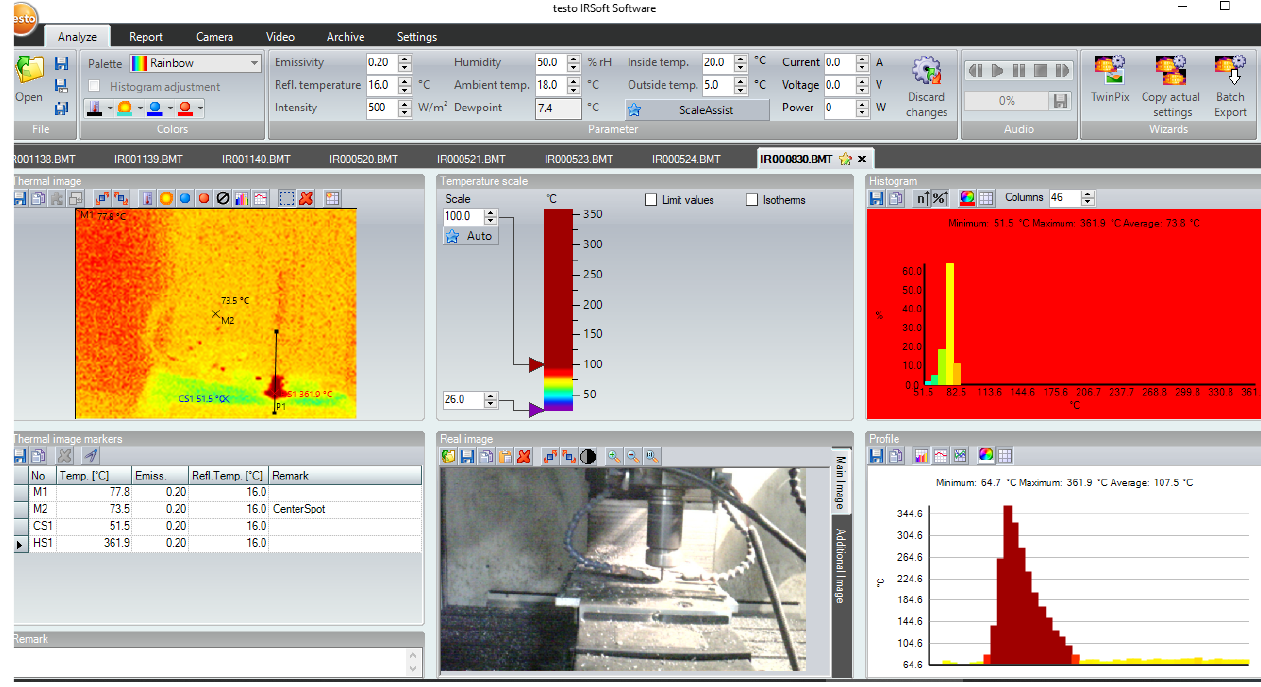
Figure 11. In-situ processing temperature measurement. Table 9. Analysis of variance of maximum temperature of